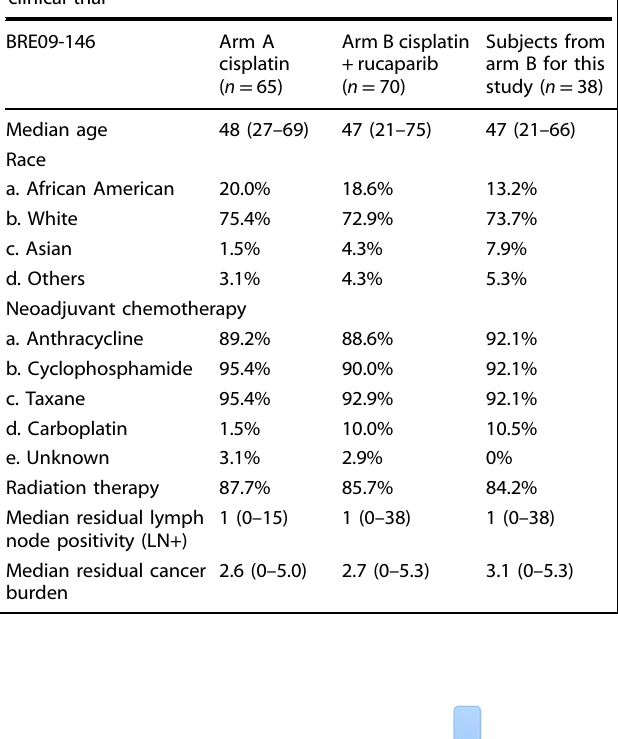
Table 1. Clinical characteristics of patients enrolled on the BRE09-146